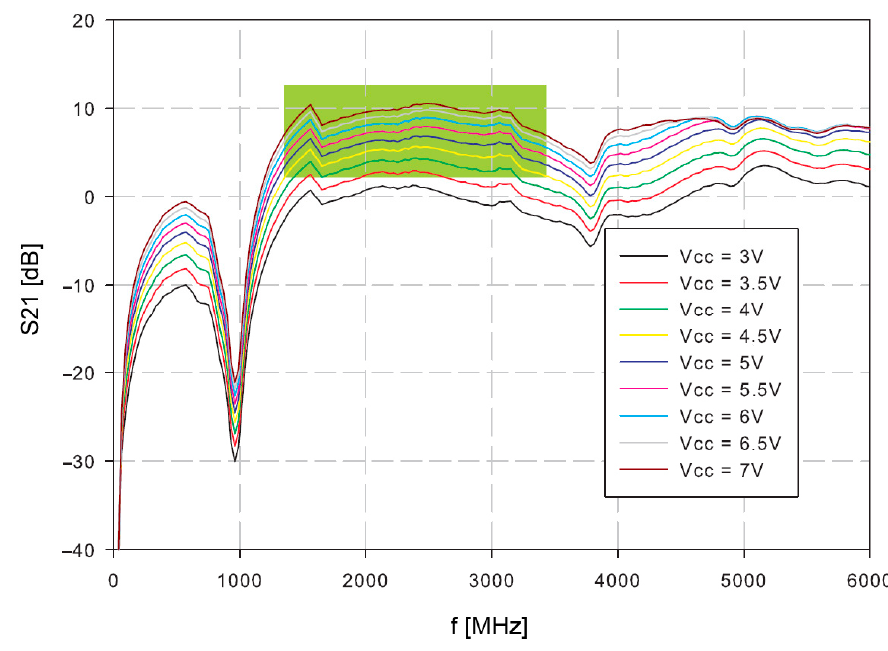
Figure 7. Measurement of S21 of the open-loop oscillator amplifier.